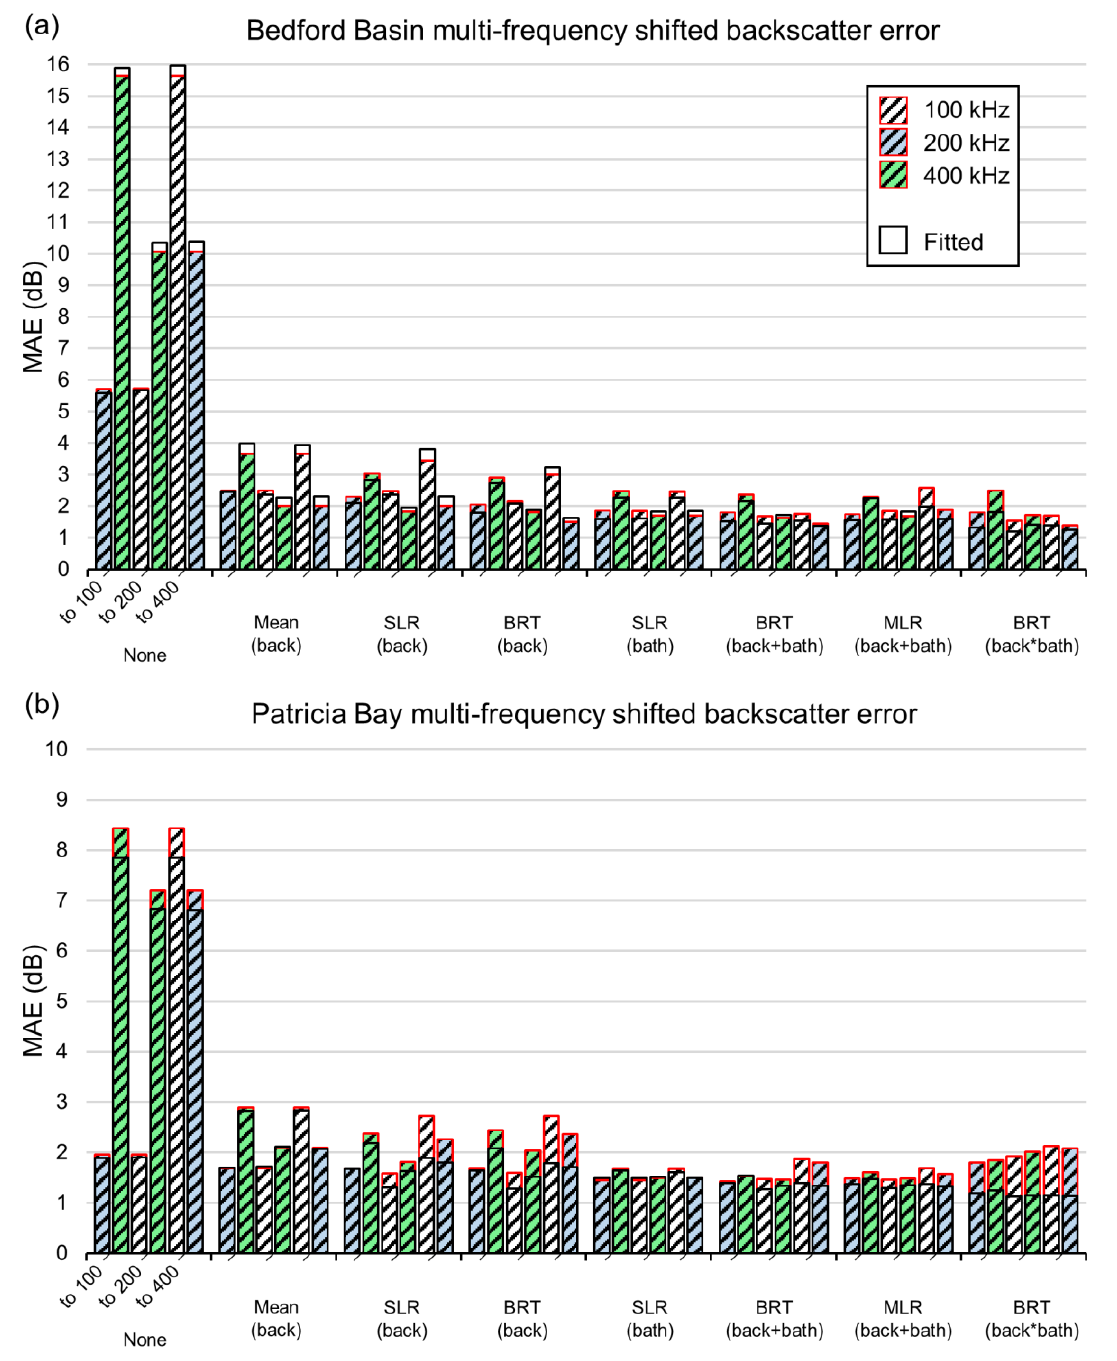
Figure 9. Fitted and test MAE of 100, 200, and 400 kHz backscatter corrected to other frequencies using seven bulk shift methods for ( a ) Bedford Basin and ( b ) Patricia Bay datasets.